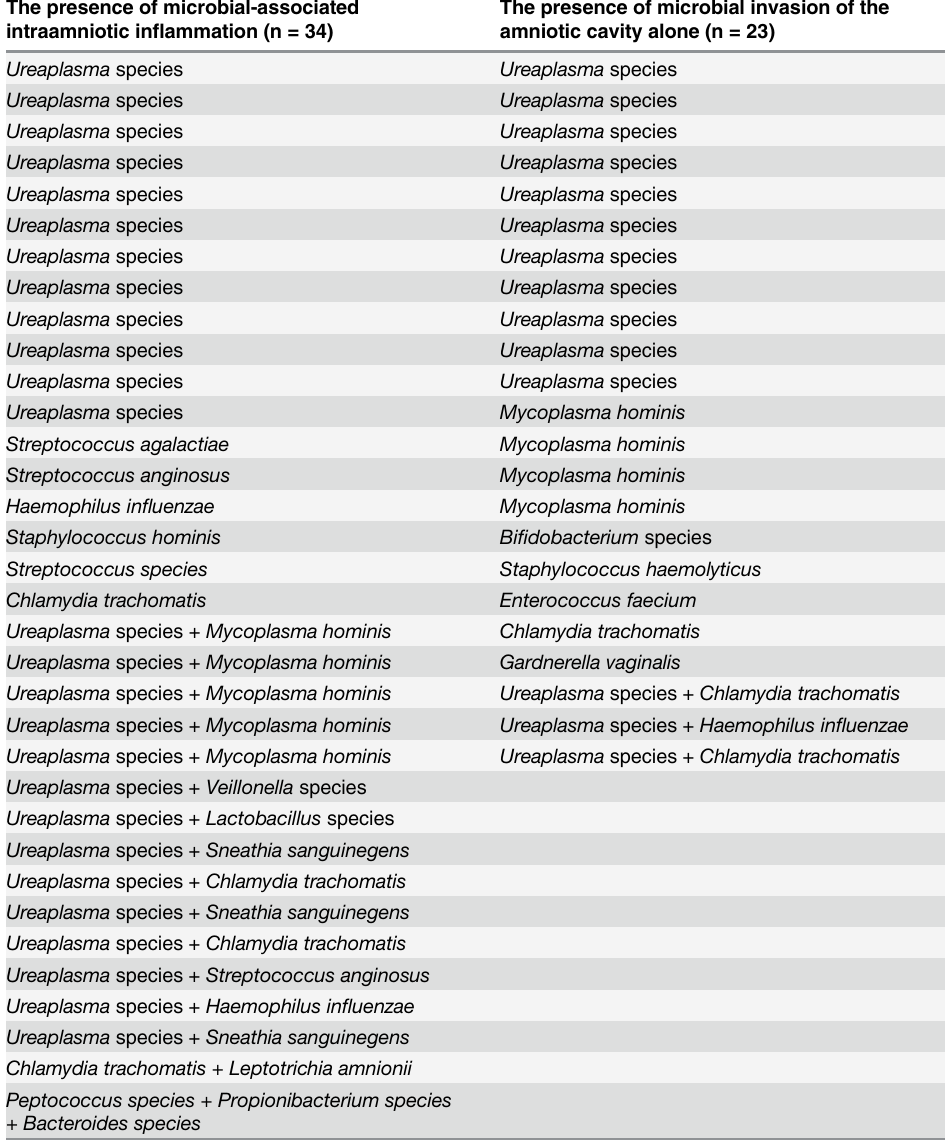
Table 3. Microorganism identified in the amniotic fluid of women with preterm prelabor rupture of membranes. The presence of microbial-associated intraamniotic in fl ammation (n = 34)